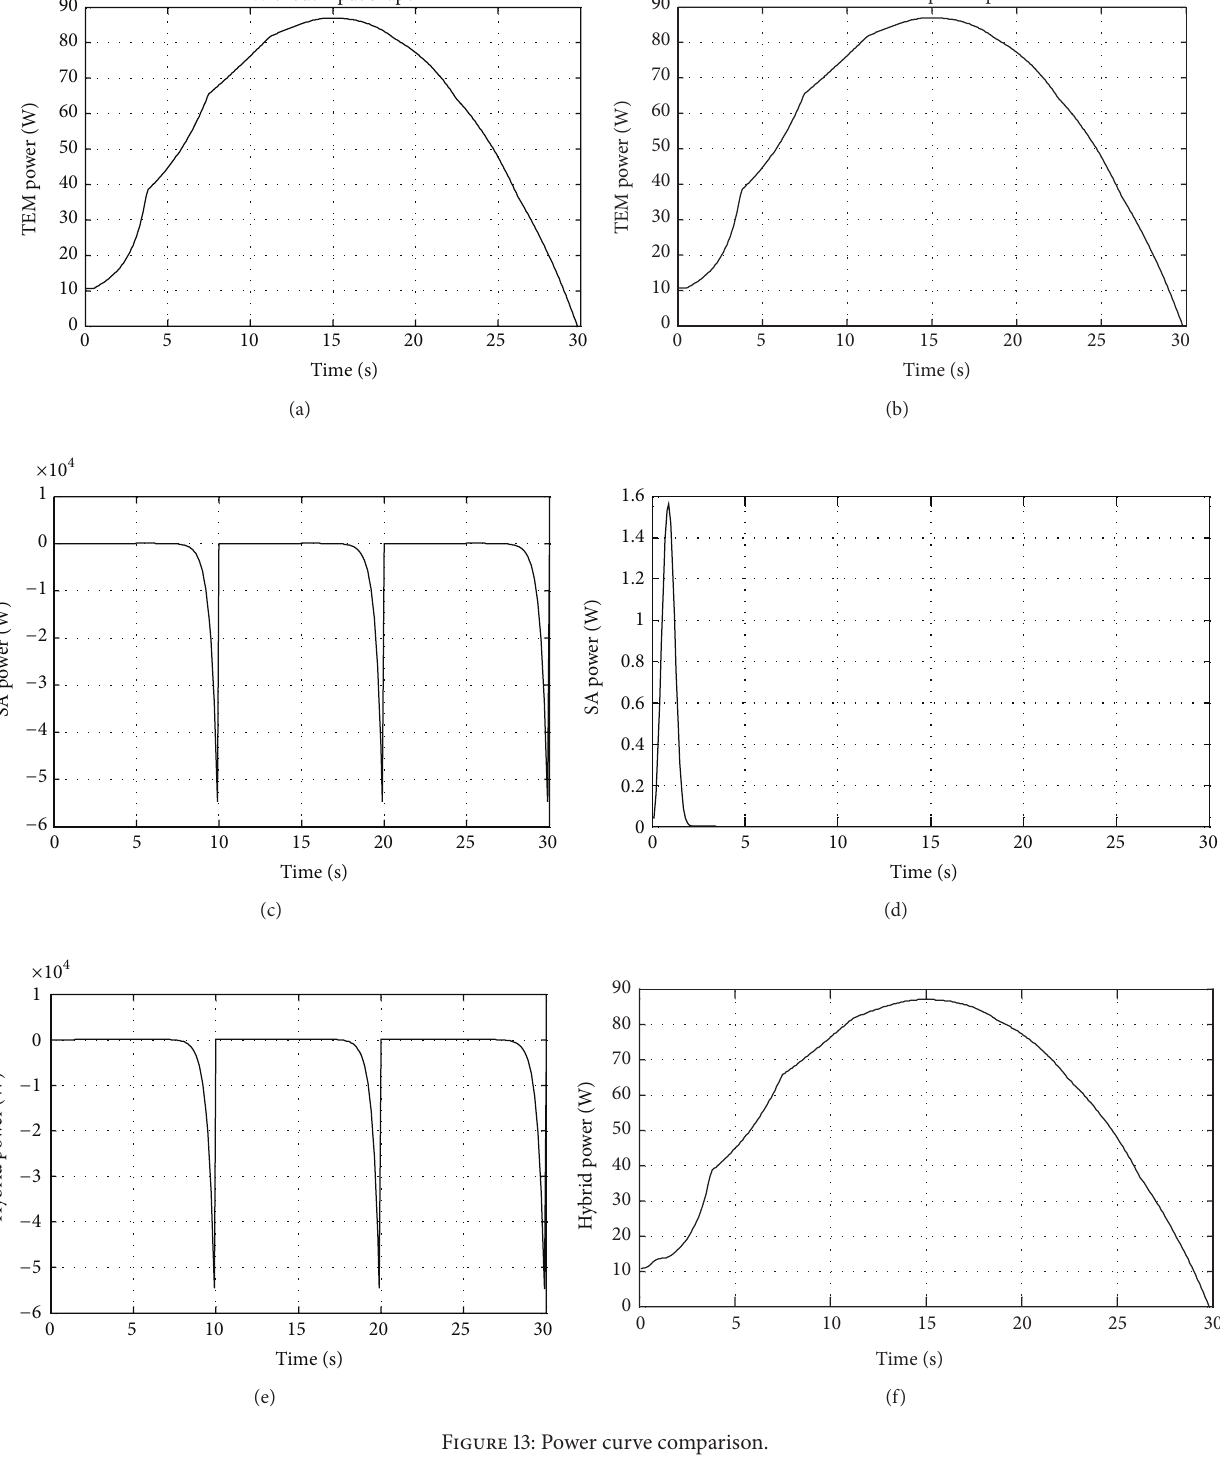
Figure 13: Power curve